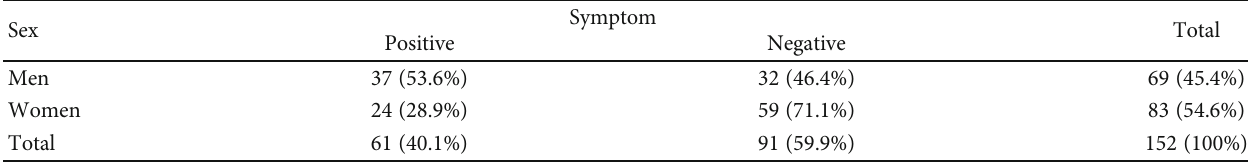
Table 3: The percentage of clinical symptoms in men and women.